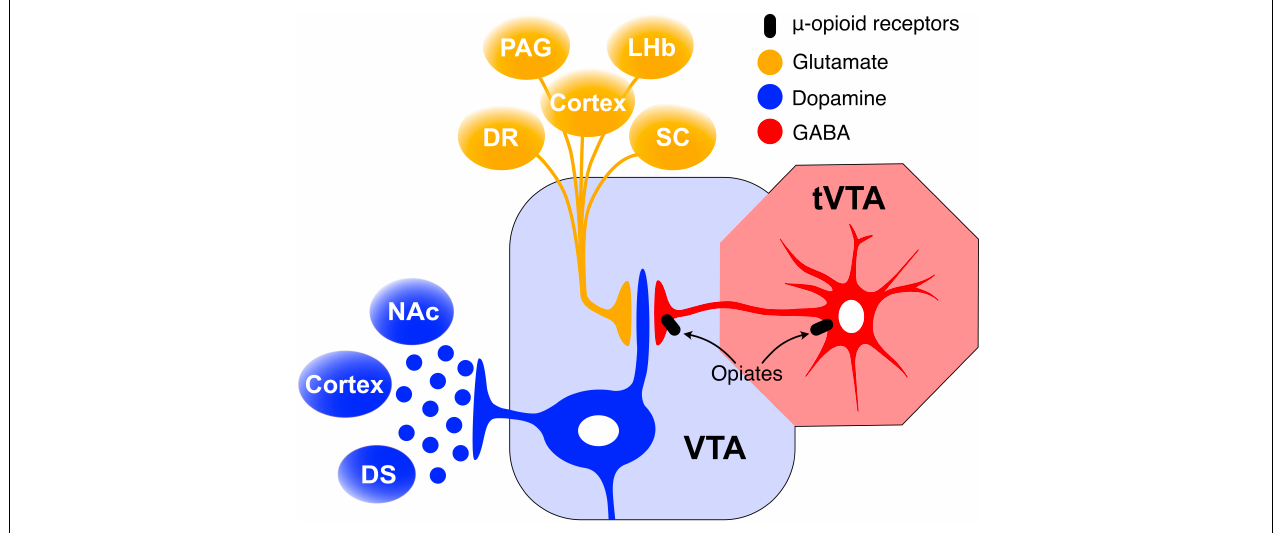
FIGURE 3 | GABA inhibition from the tVTA/RMTg mediates VTA-DA excitation. The main input of the tVTA is a glutamatergic projection from the lateral habenula (LHb) while its main output is a GABAergic projection to the VTA. tVTA-GABAergic neurons are densely packed with mu opioid receptors the activation of which decreases their firing rate. As a result, DA neurons in the VTA are disinhibited and freely transmit DA to projection sites in the NAc, DS, and cortex.